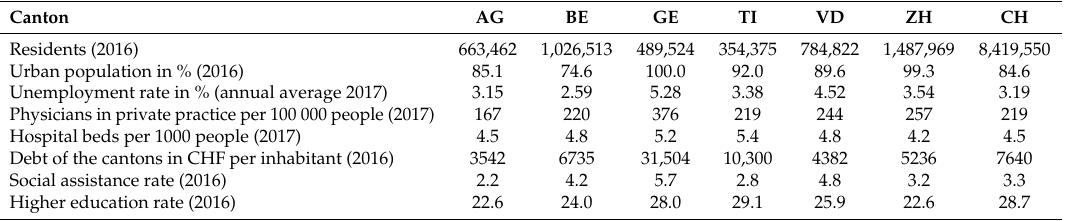
Table 1. Economic and demographic data for selected cantons and Switzerland.